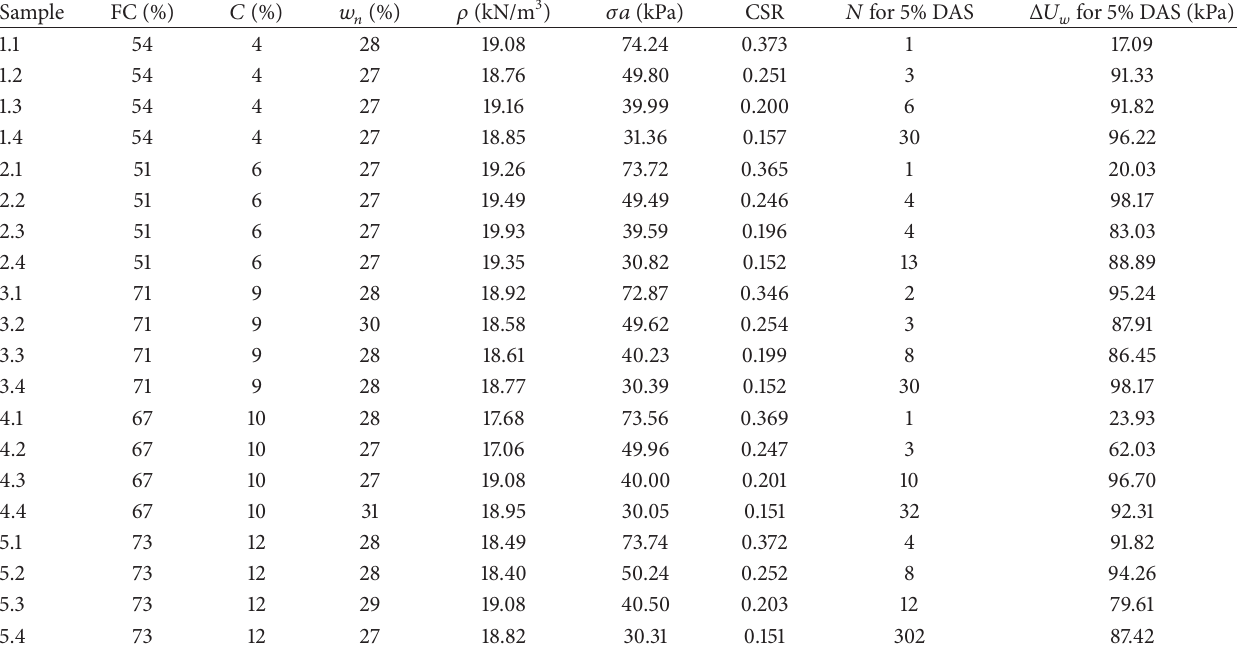
Table 2: The physical and dynamic properties of the